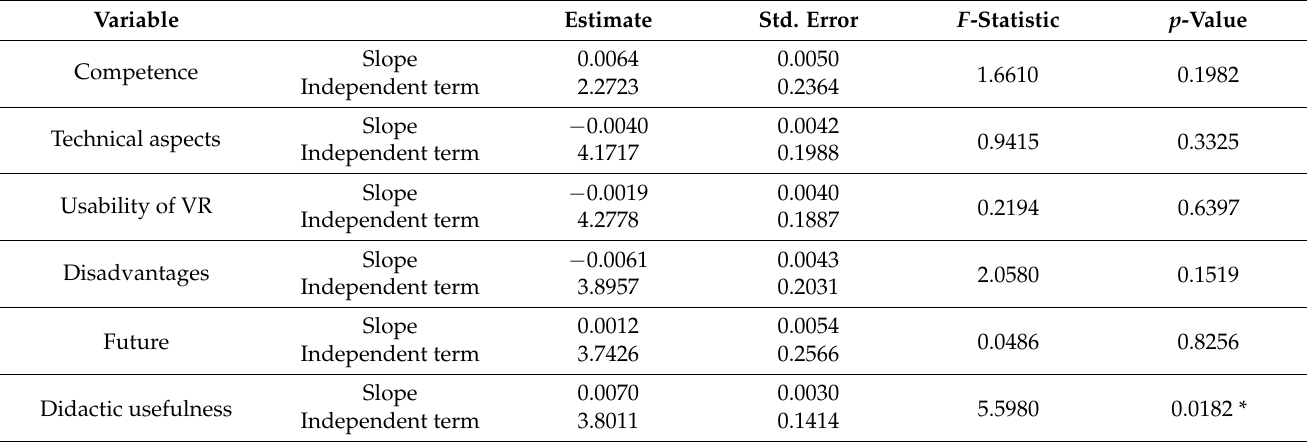
Table 6. Statistics of the linear regression model of the different factors of the questionnaire with respect to the age of the participants among the professors from private universities (270